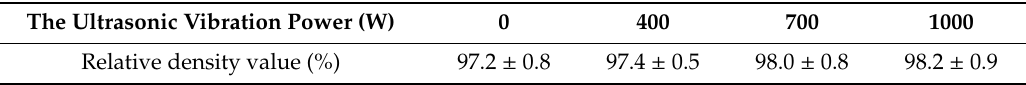
Table 3. Relative density values at di ff erent ultrasonic vibration